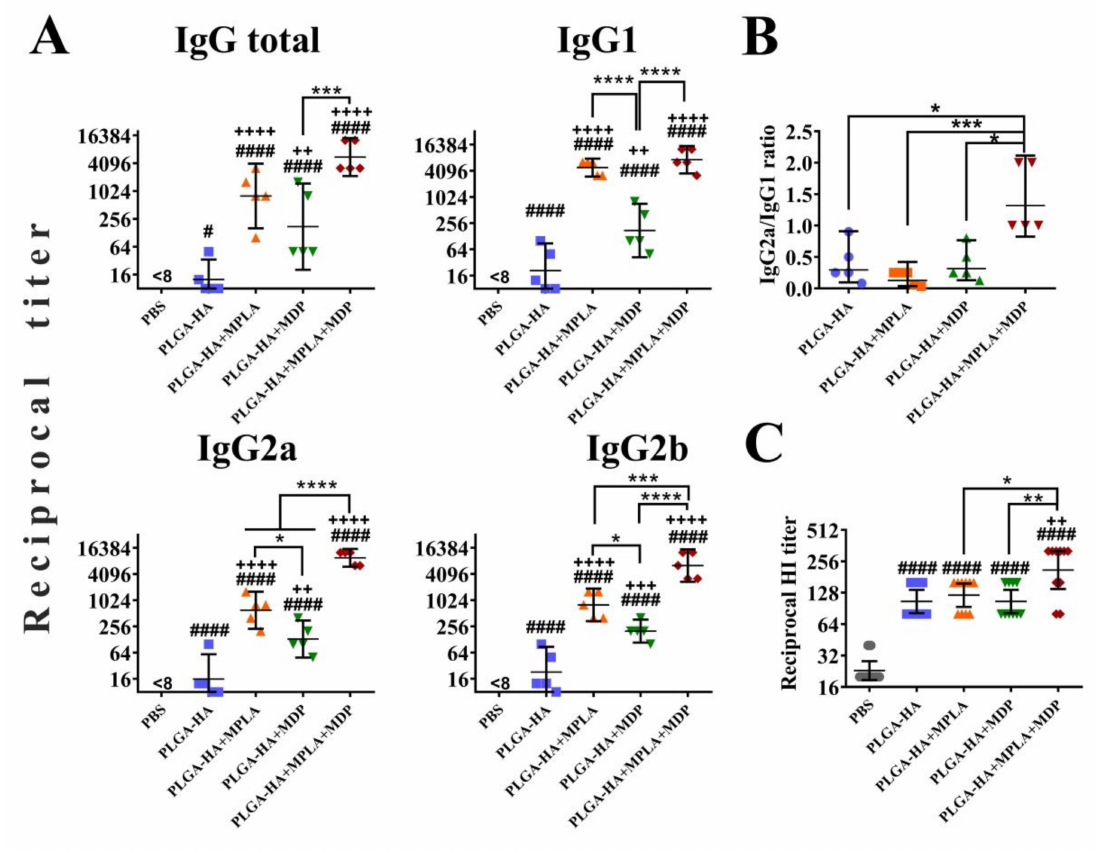
Figure 8. PLGA NPs containing both MPLA and MDP lead to a stronger humoral adaptive response in mice than NPs containing individual PRR agonists. BALB / c mice ( n = 5 / group) were i.m. immunized three times with PLGA NPs: PLGA-HA, PLGA-HA-MPLA, PLGA-HA-MDP, and PLGA-HA-MDP-MPLA. Non-immunized control mice received PBS. Blood was collected from mice 14 days after the last immunization for serum preparation. The geometric mean for 5 mice / group with 95%CI is shown. ( A ) The reciprocal titers of hemagglutinin-specific total IgG antibodies and IgG1, IgG2a, IgG2b, and IgG2c subtypes were detected in serum by ELISA. The geometric mean for 5 mice / group with 95% CI is shown. ( B ) Ratios of IgG2a / IgG1 isotype HA-specific antibodies. ( C ) The reciprocal titers of hemagglutination inhibition (HI) antibodies against the H1N1 virus in the sera of mice immunized with PLGA-HA, PLGA-HA-MPLA, PLGA-HA-MDP, and PLGA-HA-MDP-MPLA. Significant di ff erences between PLGA NPs and intact cells are indicated by hashes: # for p < 0.05 or #### for p < 0.0001. Significant di ff erences between PLGA NPs with or without PRR agonists are indicated by plus: ++ for p < 0.01, +++ for p < 0.001, or ++++ for p < 0.0001. Significant di ff erences between PLGA-HA-MPLA + MDP and the NPs with individual PRR agonists (PLGA-HA-MDP or PLGA-HA-MPLA) are indicated by asterisks and brackets: * for p < 0.05, ** for p < 0.01, *** for p < 0.001, or **** for p < 0.0001. p -values were calculated using one-way ANOVA post-hoc Tukey’s test ( A , C ) and Kruskal-Wallis post-hoc Dunn’s test ( B